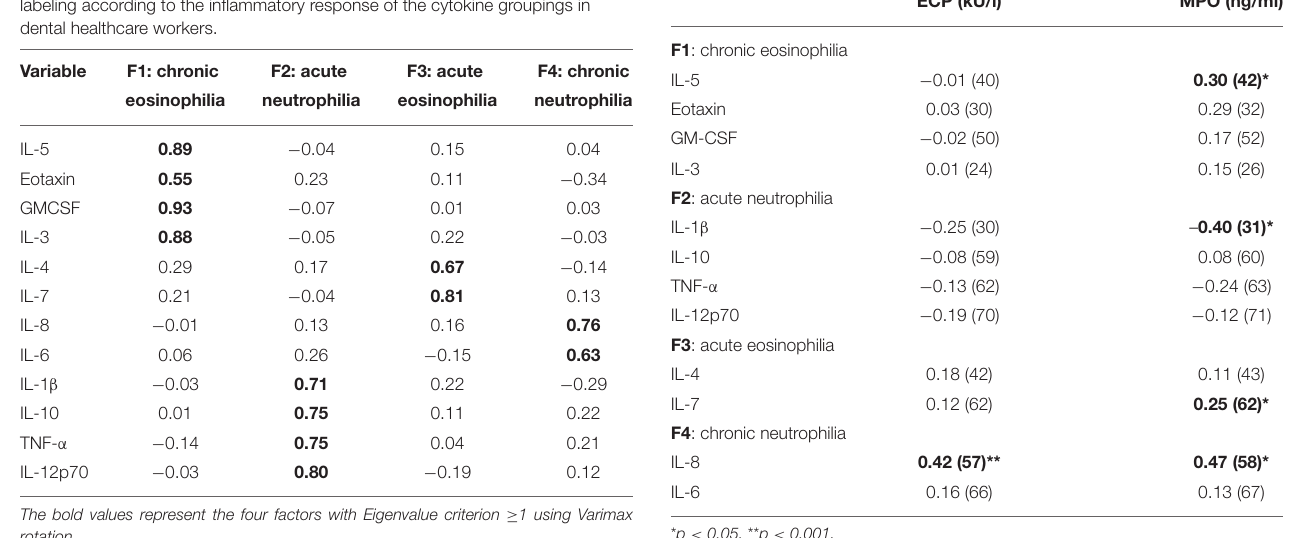
The bold values represent the four factors with Eigenvalue criterion ≥ 1 using Varimax rotation.